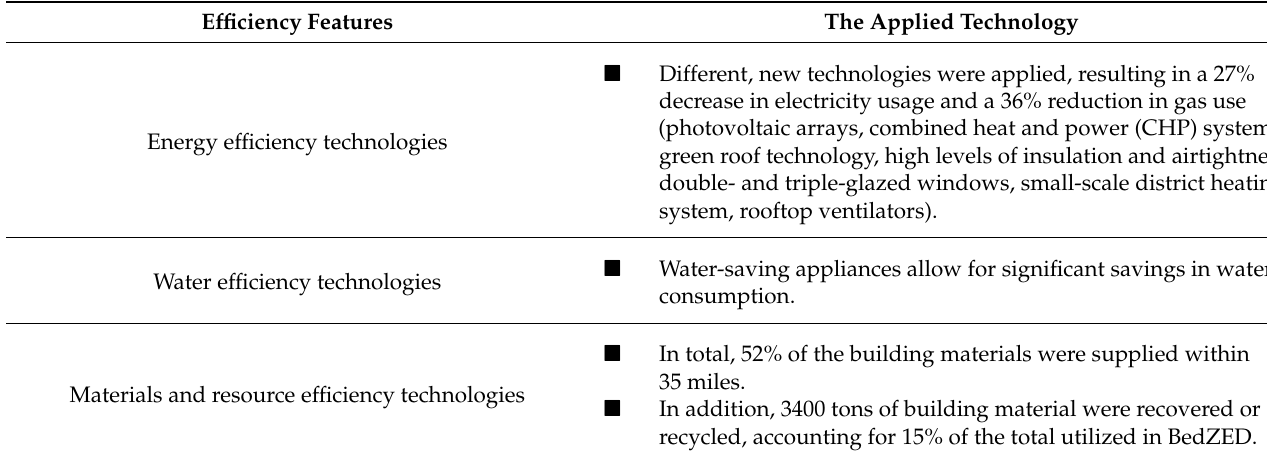
Table 4. The innovative applications employed in the BedZED project [50]. Efficiency